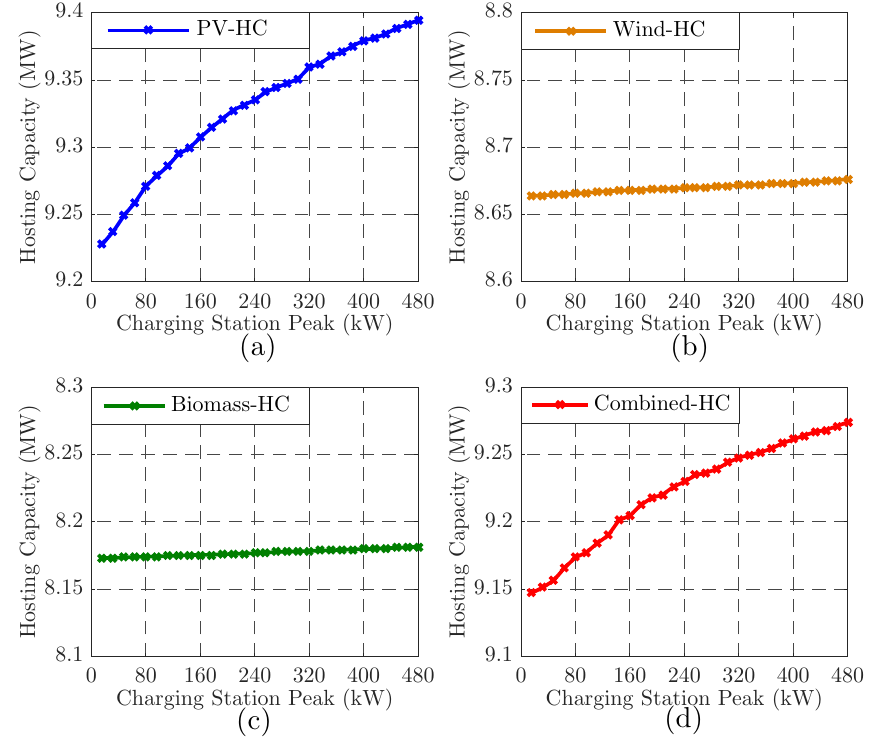
Figure 7. The effect of charging stations’ demands on the HC obtained via the proposed DRO-HC method with τ = 1% for different technologies including: ( a ) PV; ( b ) wind; ( c ) biomass; and ( d ) combination of PV, wind and